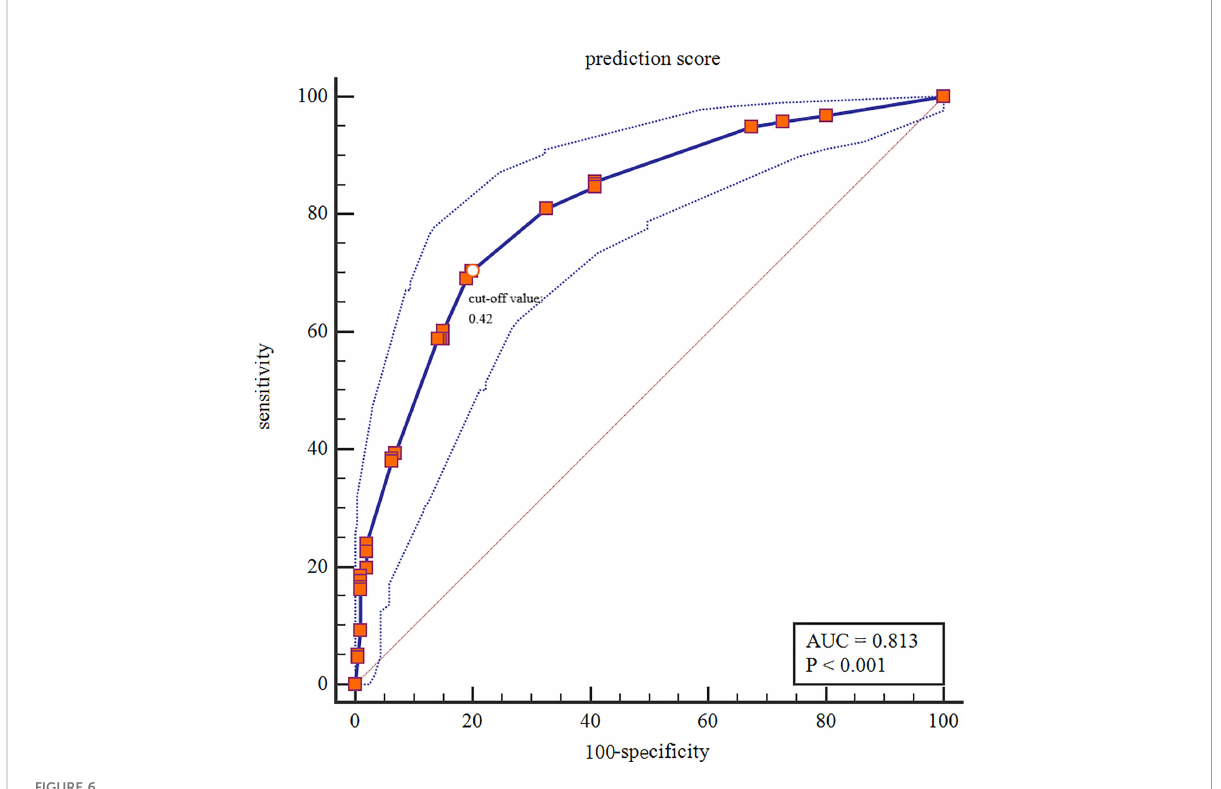
FIGURE 6 Categorization threshold of Prediction